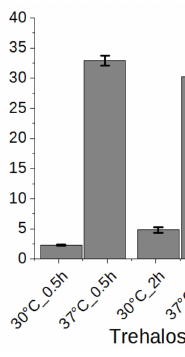
Figure 6. The change of trehalose in yeast cells under heat stress for 0.5, 2, or 8